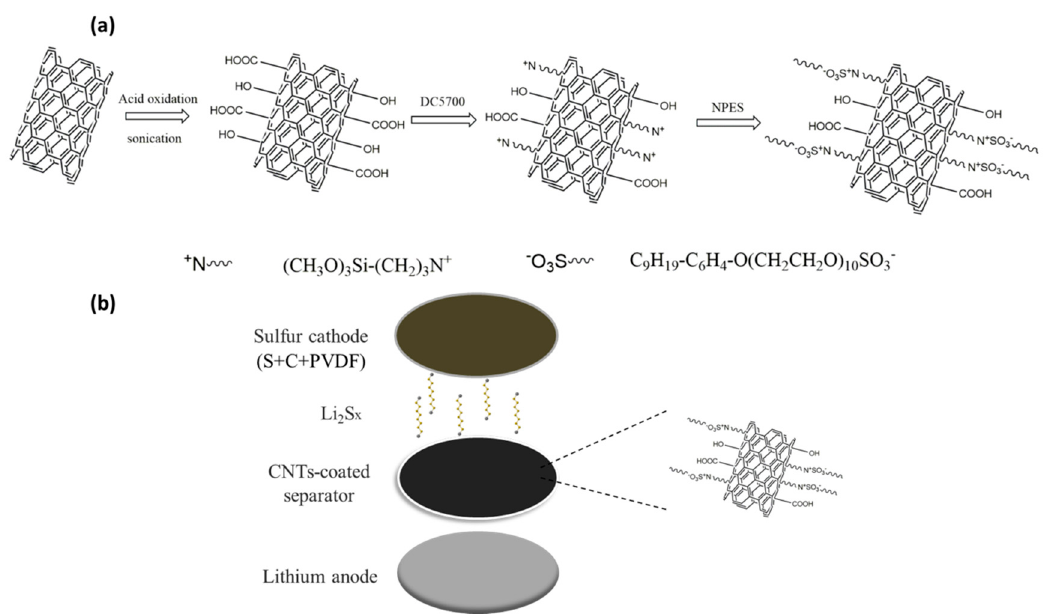
Figure 1. Schematic illustration of ( a ) organic modification process of carbon nanotubes and ( b ) cell configuration of lithium-sulfur (Li-S) batteries.